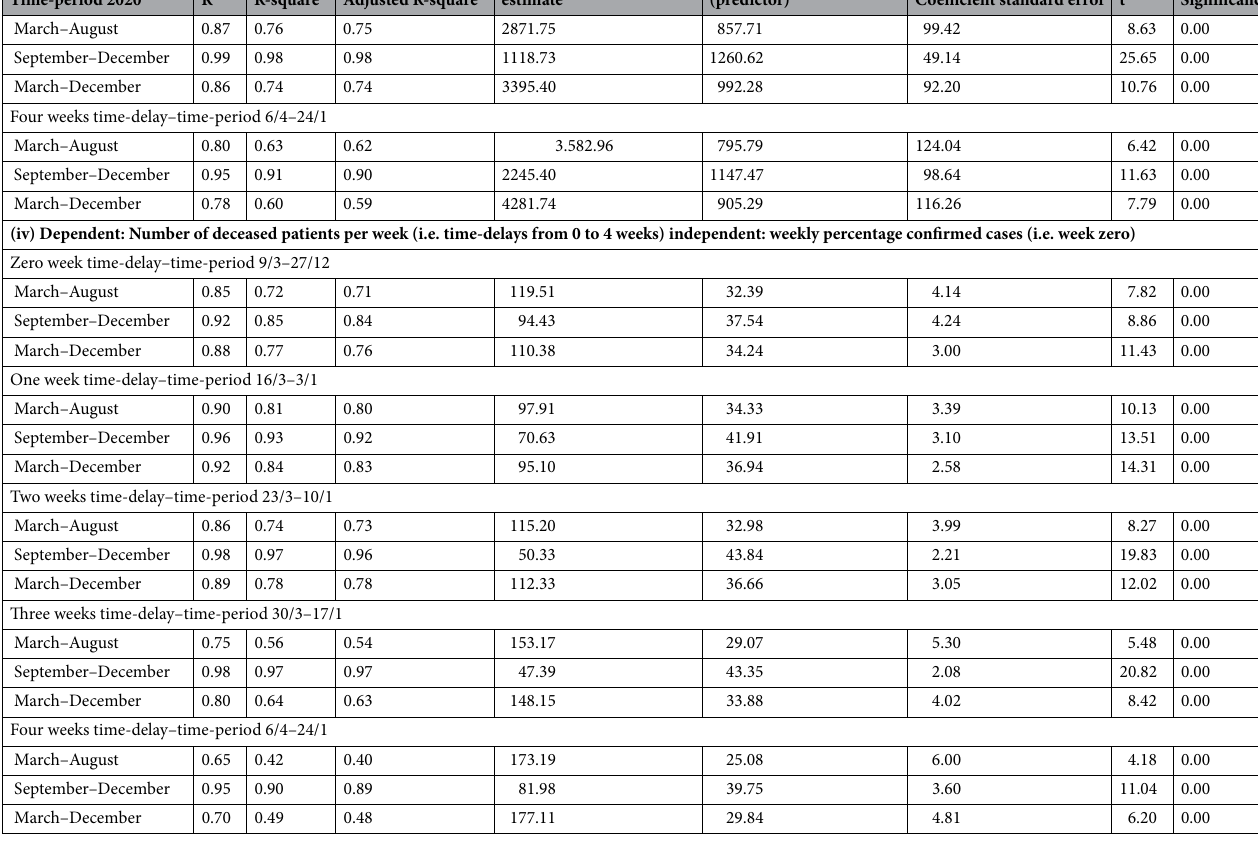
Table 1. Regression statistics.